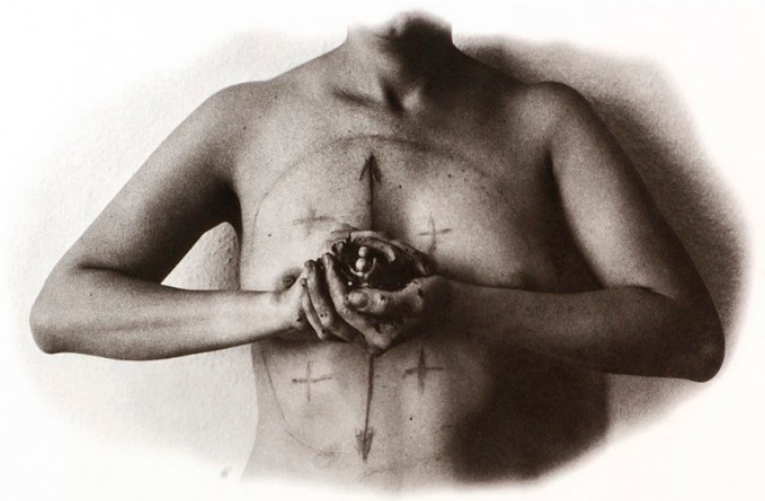
Figure 6. Marta Mar í a P é rez Bravo, Macuto , 1991.Courtesy of the Figure 6. Marta María Pérez Bravo, Macuto , 1991.Courtesy of the artist.